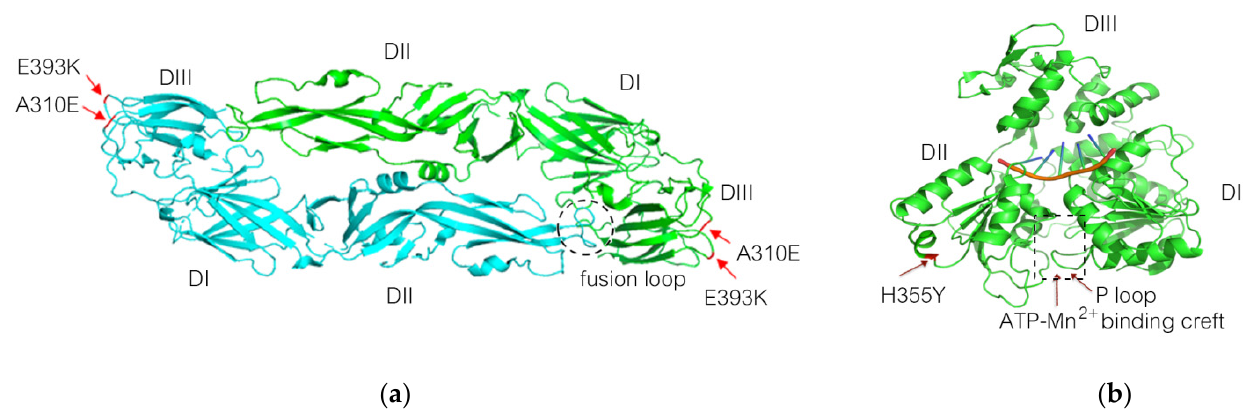
Figure 2. ( a ) Two E mutations, A310E and E393K of ZIKV-PDK7-S3 and ZIKV-PDK7-S1.4, are mapped on the ZIKV E protein dimer using PBD: 5LBV as a template. Both mutations are located at domain III (DIII) of the E protein as red indicates. ( b ) NS3 mutation H355Y of ZIKV-PDK7-S3 and ZIKV-PDK7-S1.4 is mapped onto the ZIKV NS3 protein using PBD: 5GJB as a template. The mutation is located at domain II (DII) of the helicase–RNA complex. The dotted square presents an ATP/Mn2+ binding site in a cleft of domain I and II (DI and DII), which is composed of residues G197, K200, T201, R202 (P loop), E286, N330, R459, and R462.